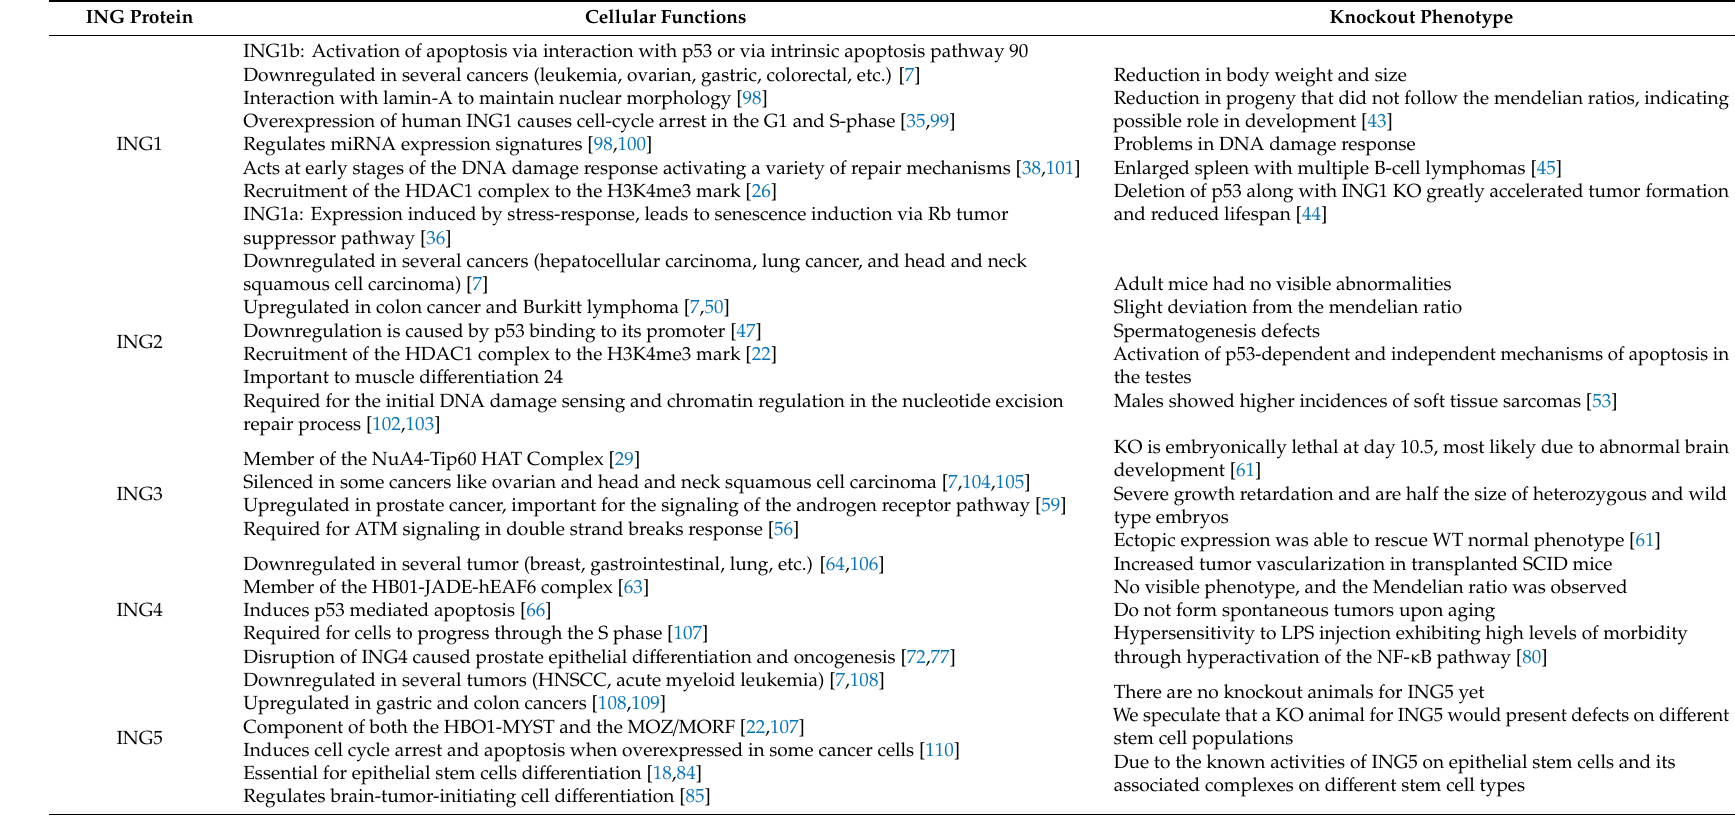
Table 1. A summary of the most important ING protein functions from in vitro cell studies and known knockout (KO) phenotypes in mice. Knockouts for ING1 , ING2 , and ING4 have been reported. Knockouts for ING3 and ING5 have been produced but not yet reported. The ING3 knockout is the only one to prove to be embryonic